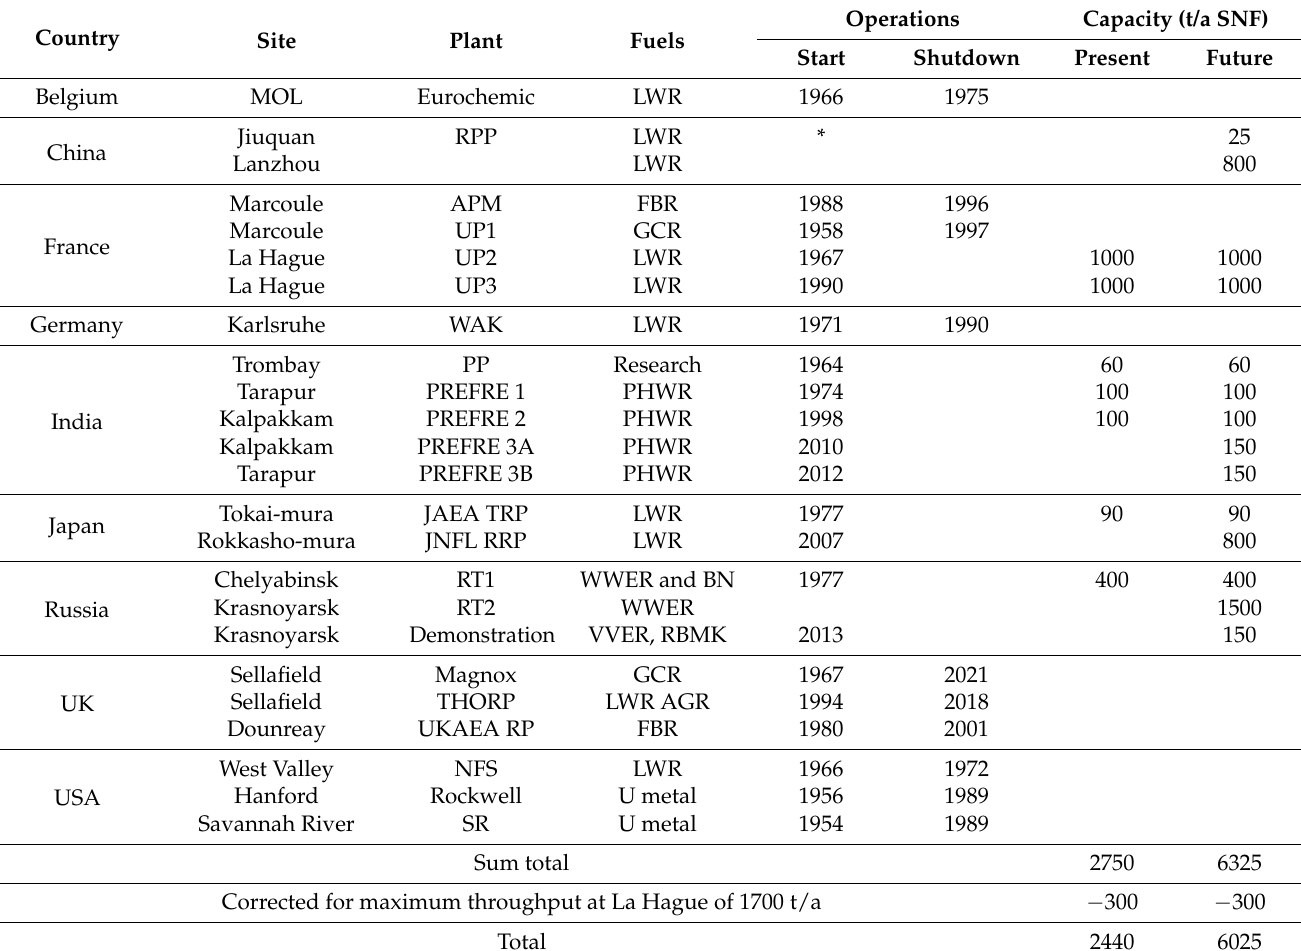
Table 2. World reprocessing capacity (based on the PUREX process and adapted from